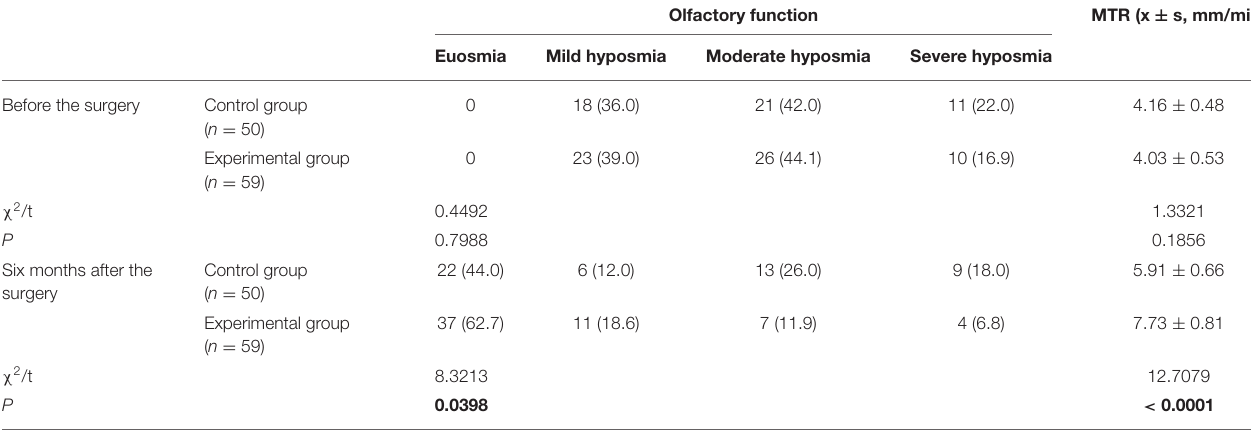
TABLE 7 | Comparison of olfactory function and MTR of patients between the two